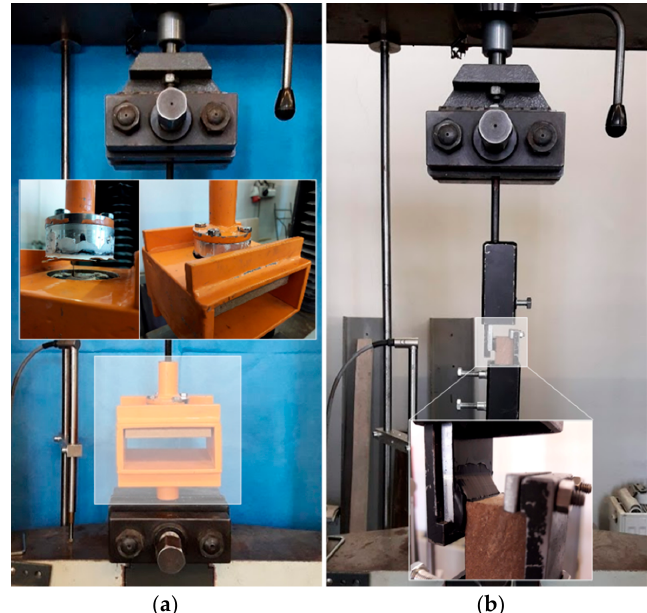
Figure 4. Test setup: ( a ) tensile test; ( b ) shear test.